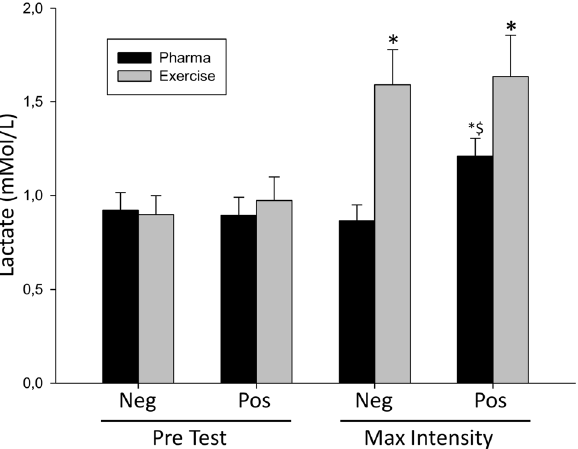
Figure 5. Serum lactate levels (mmol/L) in samples obtained before the test and at the time of maximum intensity. Comparison between positive and negative stress test results. *Indicates statistical difference ( P < 0.05) from pre-test and $ between negative and positive